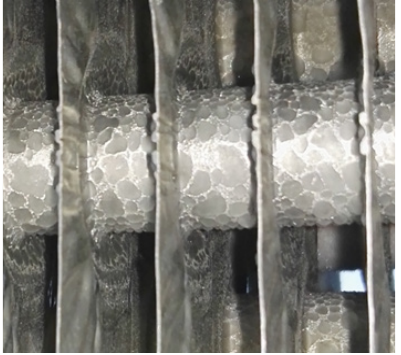
Figure 6. The freezing phenomenon of evaporator tube in front of the air-cooler.